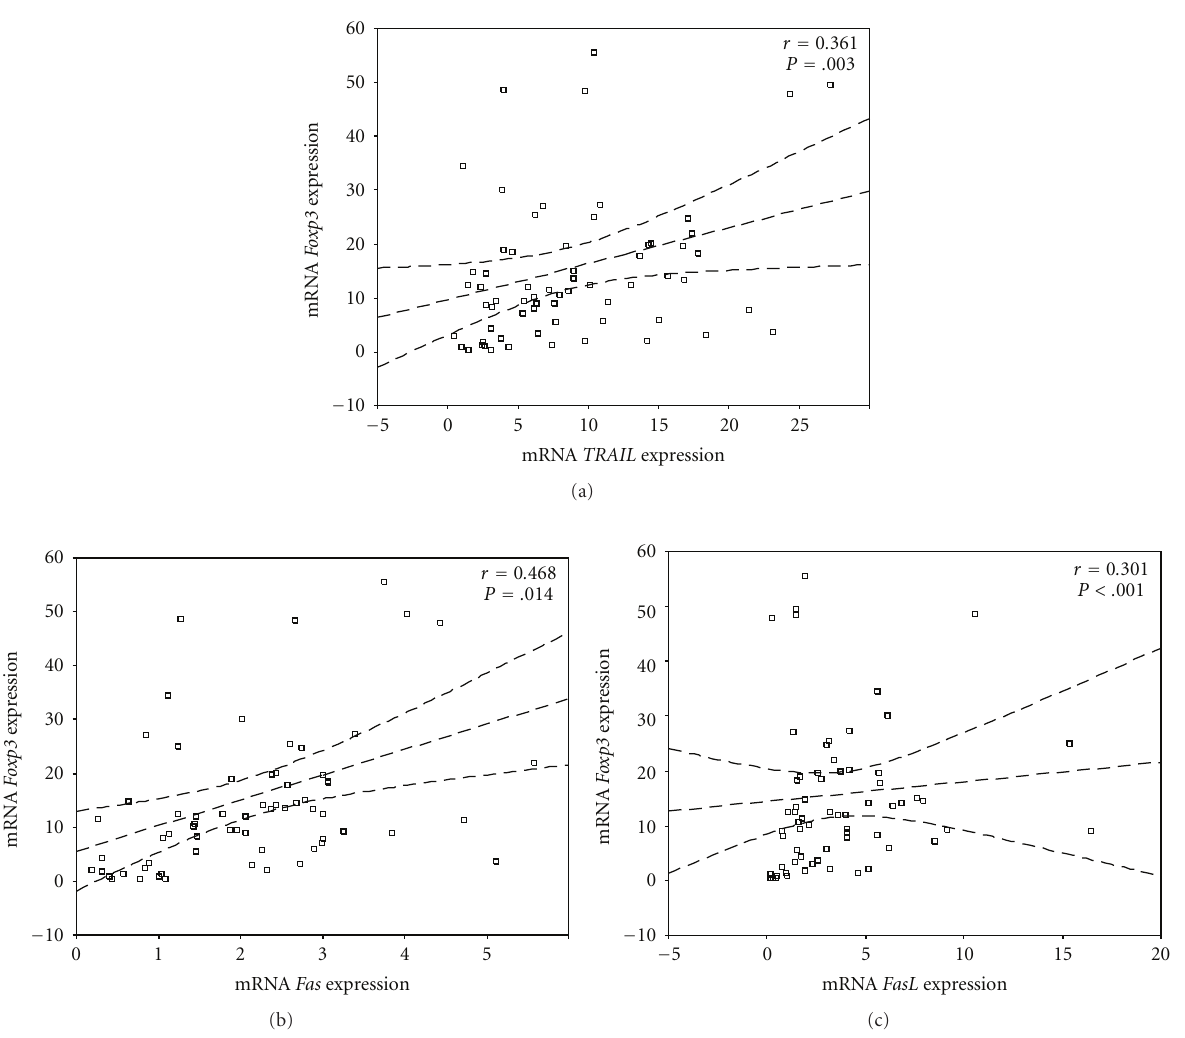
Figure 2: Results of the Spearman’s rank correlation coe ffi cient between Foxp3 and TRAIL (a), Foxp3 and Fas (b), and Foxp3 and FasL (c), in all disease subgroups